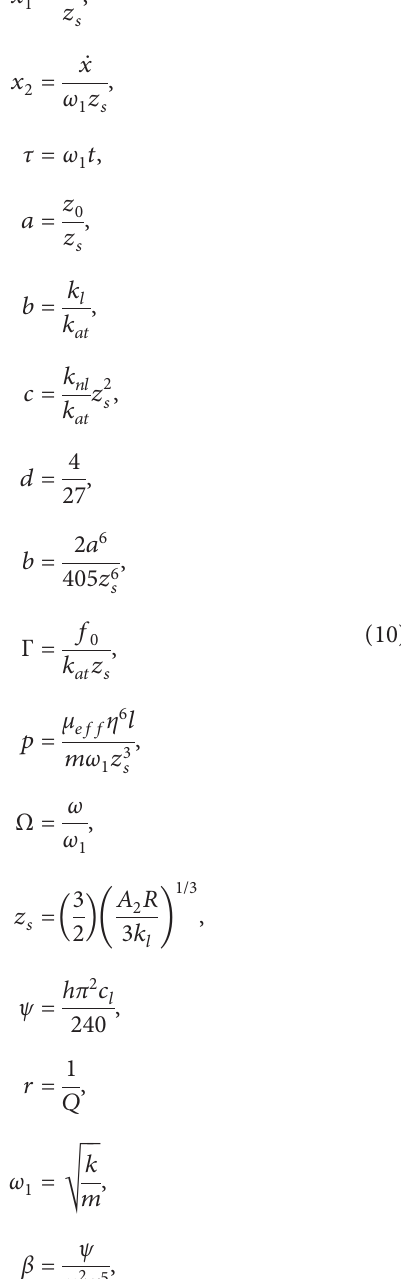
Table 1: Parameters of the AFM-TM model [13,